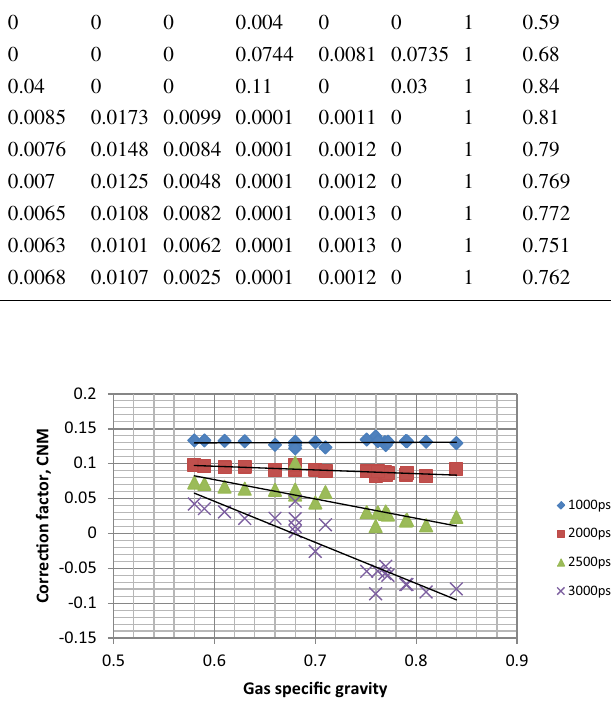
Fig. 3 Calculation of C NM at 140 (cid:3) F and different pressures